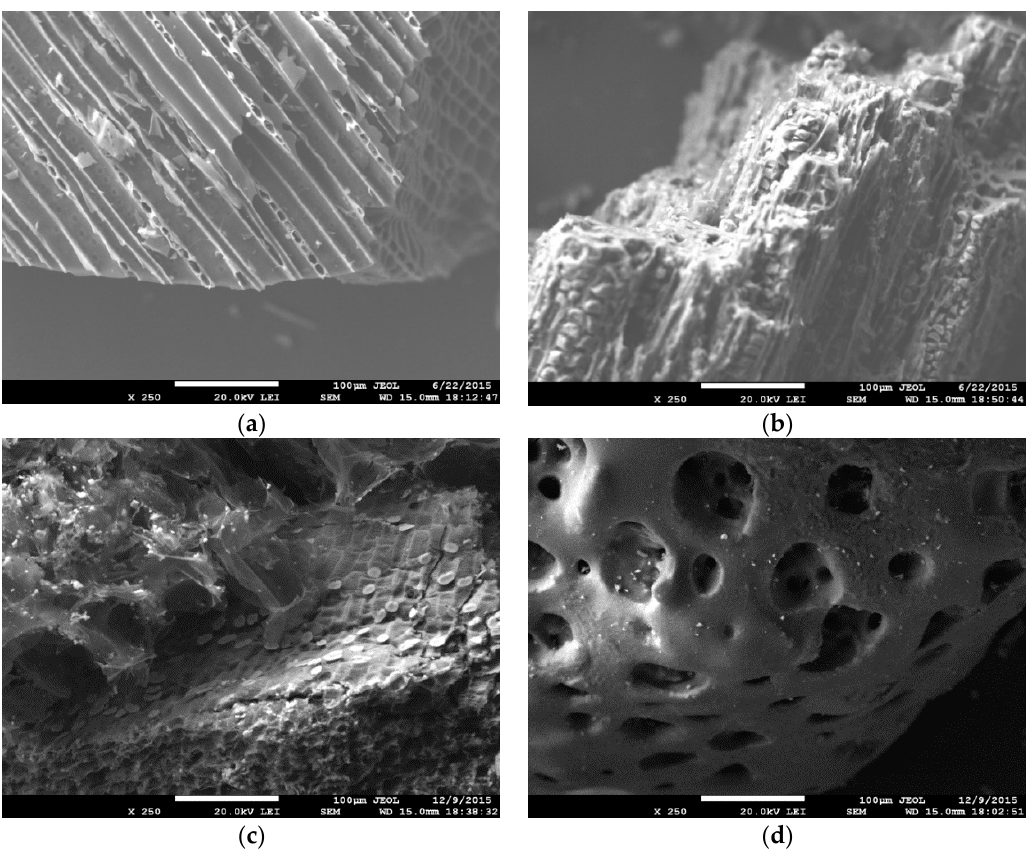
Figure 2. Scanning electron microscopy (SEM) - images of biochar derived from wood chips ( a ), garden green waste ( b ), corn cobs ( c ), and sewage sludge ( d ) at magnification 250× (with permission of authors— Micháleková-Richveisová et al. [91]).